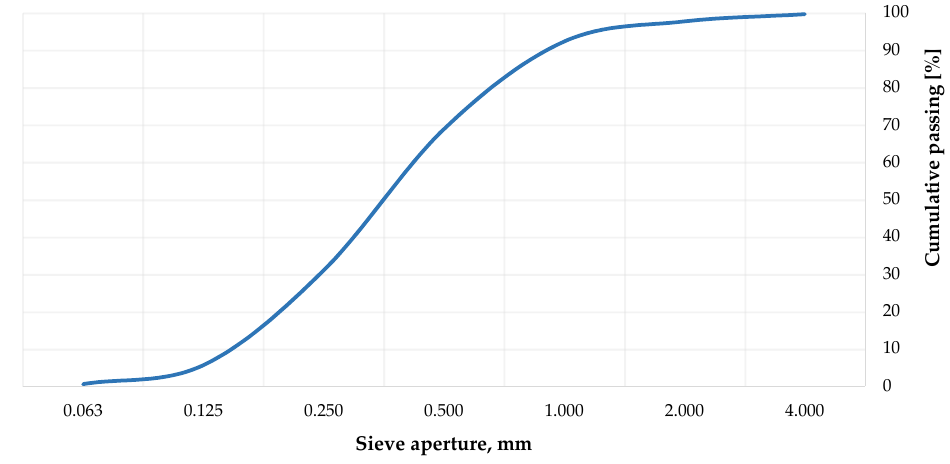
Figure 2. Sand grading curve with a maximum aggregate size (MAS) of 4 mm.